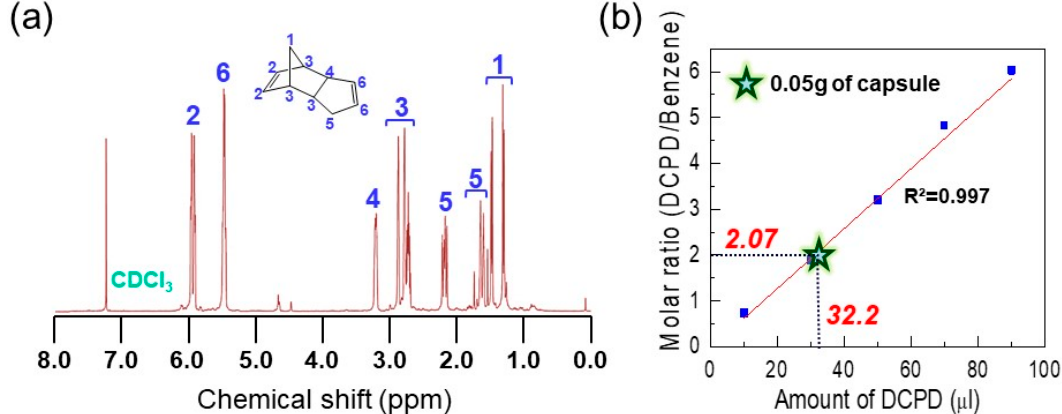
Figure 3. ( a ) 1 H-NMR spectrum of the extracted dicyclopentadiene (DCPD). ( b ) The calibration line of the DCPD/benzene molar ratio with function of the known volume of DCPD (10, 30, 50, 70, 90 μ L). The solid line represents the result of a least squared linear fit with R 2 = 0.997. Star-shaped mark represents the DCPD/benzene molar ratio value measured from 0.05 g of mechanically-enhanced microcapsules and corresponding amount of DCPD.